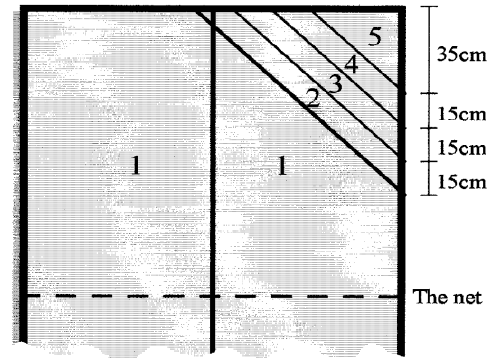
Fig1. Liao's & Master's Accuracy Test of Backhand in Table Tennis